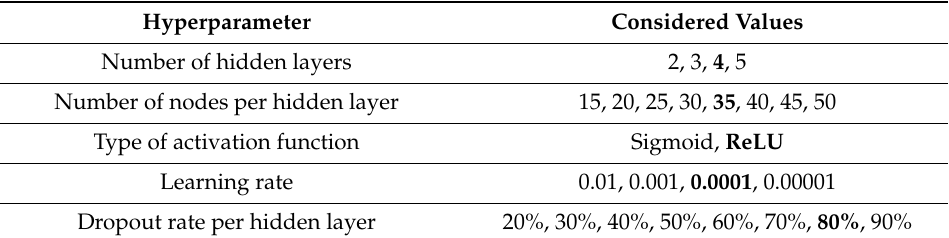
Table 3. Hyperparameters considered (selected parameters in bold